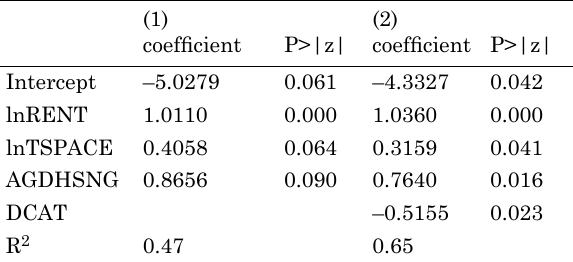
Table 3. The results of the two regression